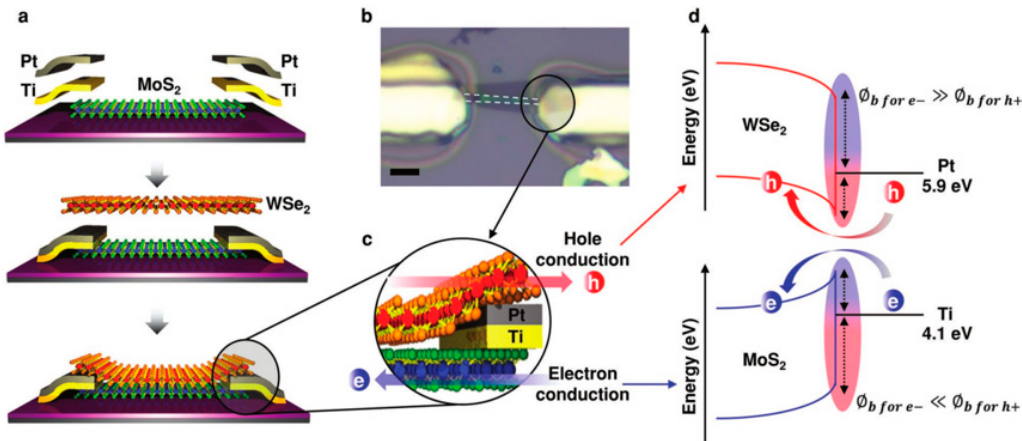
Figure 33. ( a ) Schematic of fabrication, a WSe 2 /MoS 2 hetero-structure dual-channel FET. ( b ) Optical picture of a processed transistor. The dashed line shows the bottom MoS 2 layer, ( c ) schematic of electron and hole transport in one channel of dual-channel FET, and ( d ) band diagram WSe 2 -Pt metal (top) and MoS 2 -Ti. The symbol ϕ b in the picture stands for the barrier for hole and electrons [206].